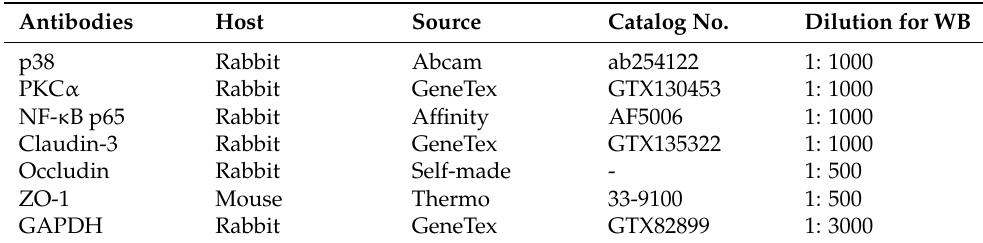
Table 5. The information of antibodies used for Western